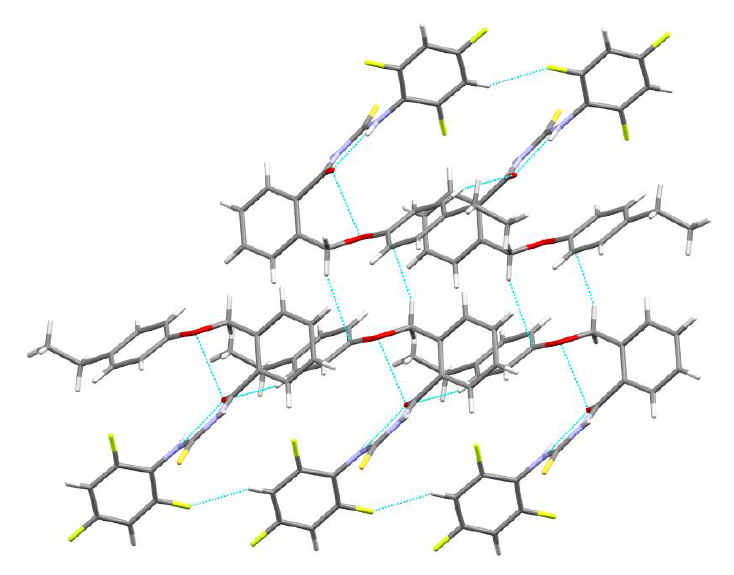
Figure 3. Details of supramolecular interactions in the crystal packing of 5d.